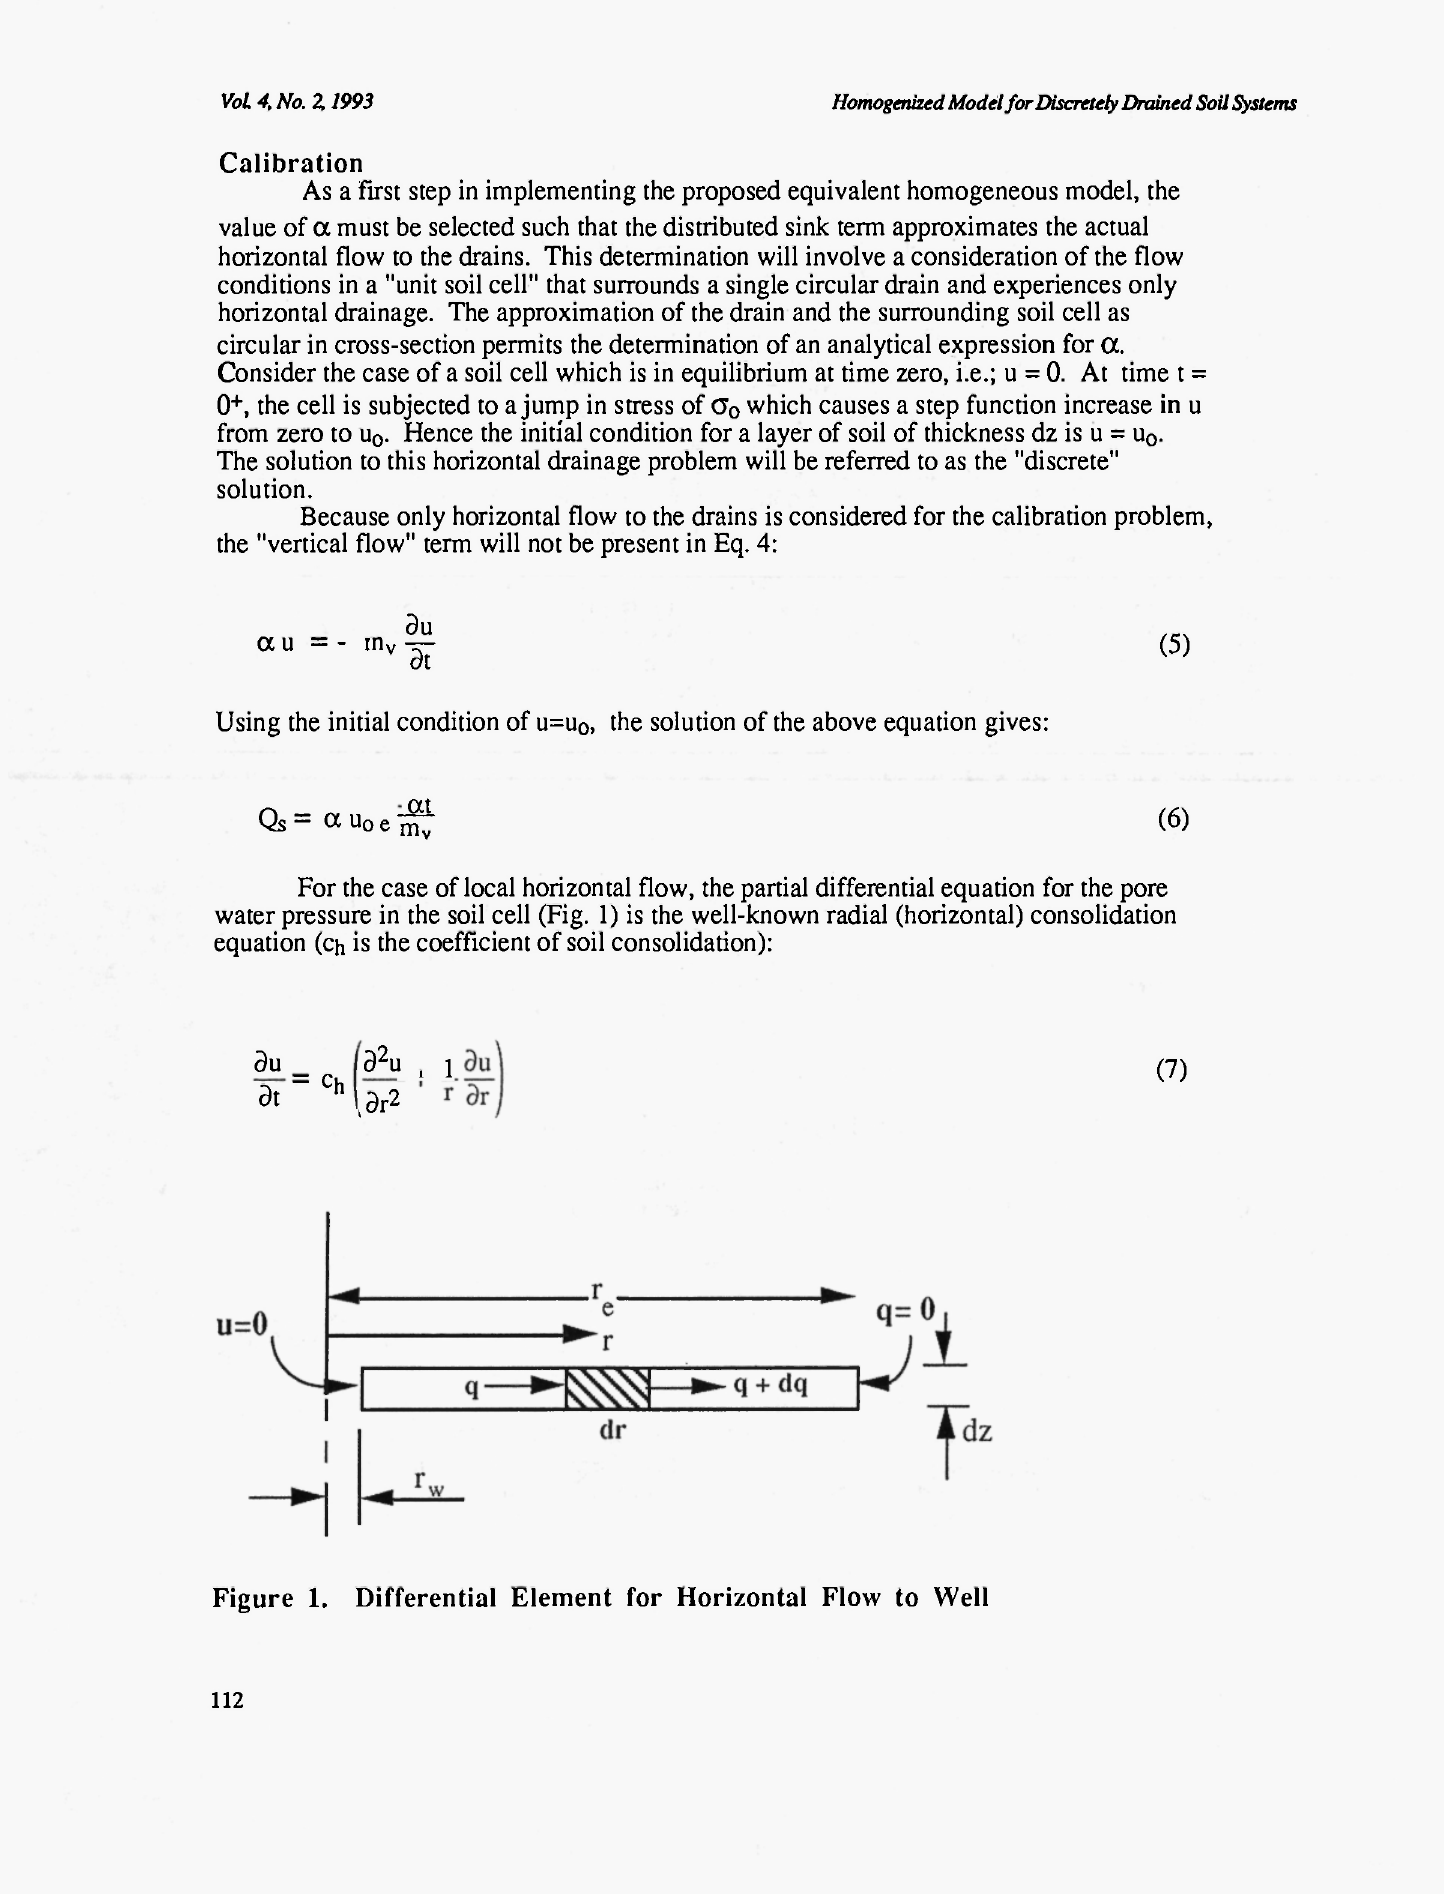
Figure 1. Differential Element for Horizontal Flow to